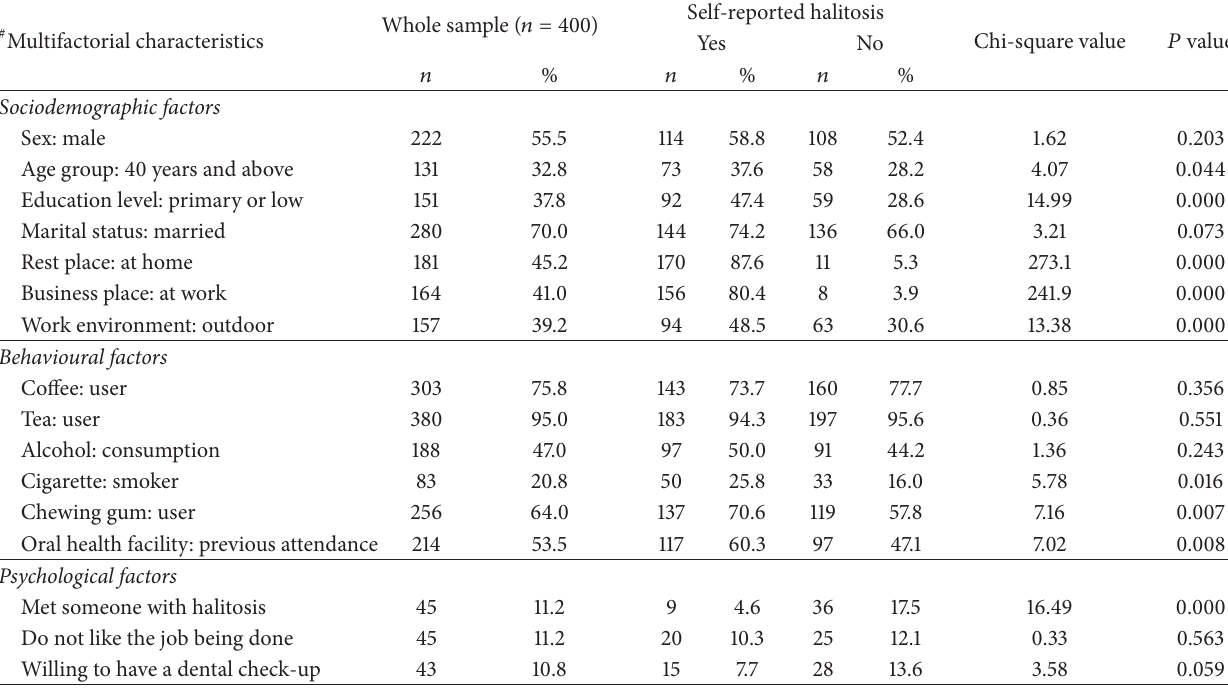
Table 5: Bivariate analysis: self-reported halitosis in relation to sociodemographic, behavioural, and psychological factors. # Multifactorial characteristics